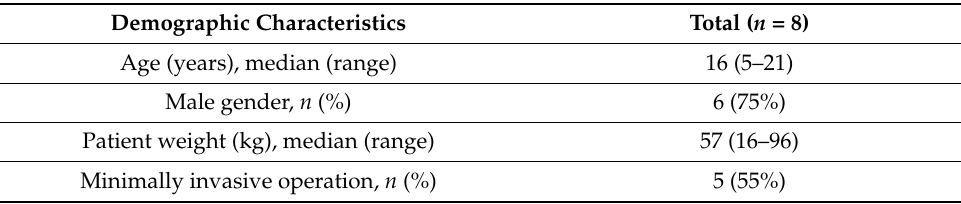
Table 2. Patient